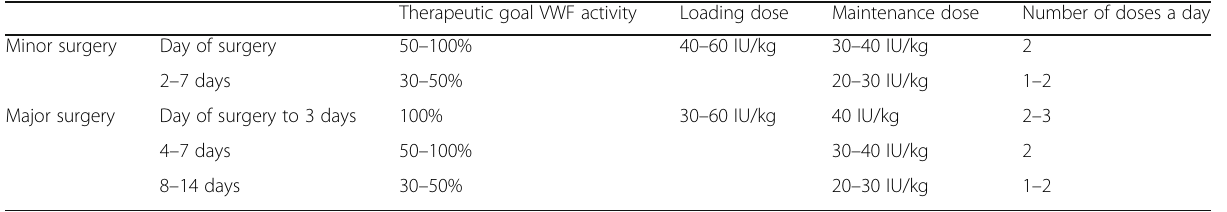
Table 1 Perioperative coagulation management on administration of FVIII/VWF concentrates in patients with